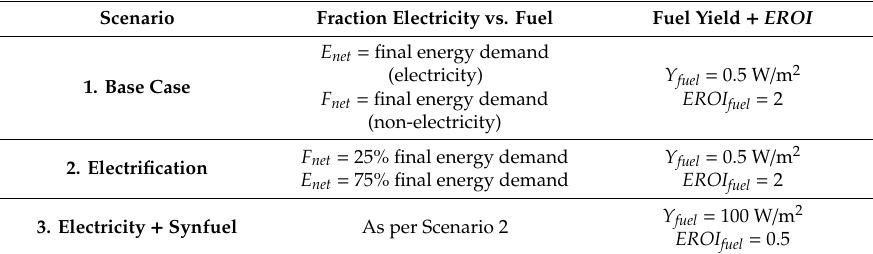
Table 3. Scenario parameters.